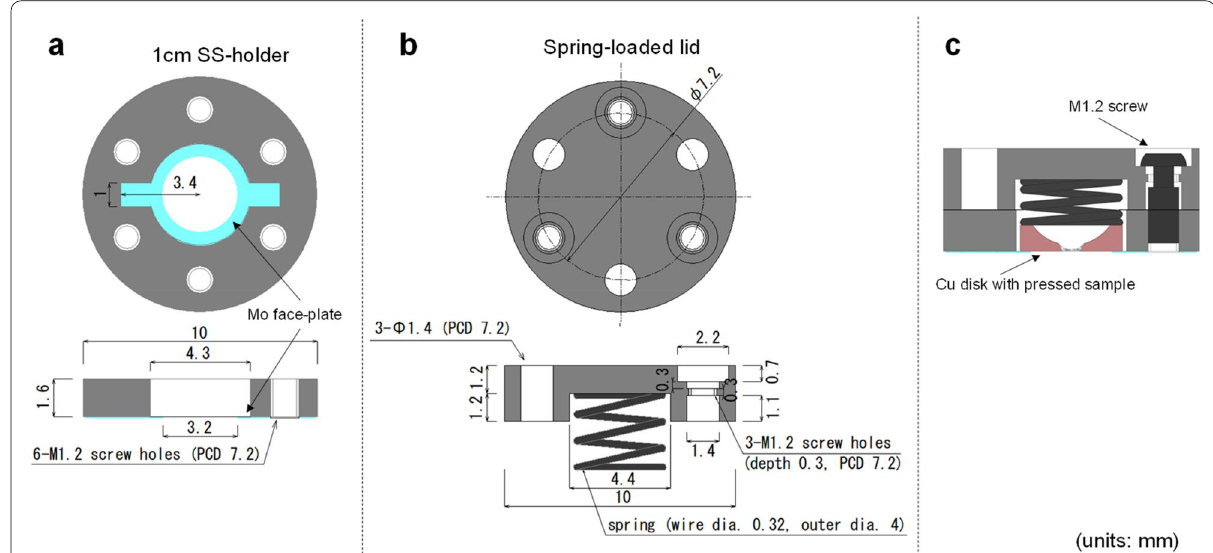
Fig. 5 Schematic diagram of the stainless-steel (SS) holder that had an outer diameter of 1 cm and was named as 1 cm SS-holder. a . Main block with a thin (50 µm) tungsten (W) face plate. b . Spring-loaded lid with a spring coil. c. Cross-section image when the Cu disk was installed in the 1 cm SS-holder. The sample surface was adjusted to the 50 µm below the W face